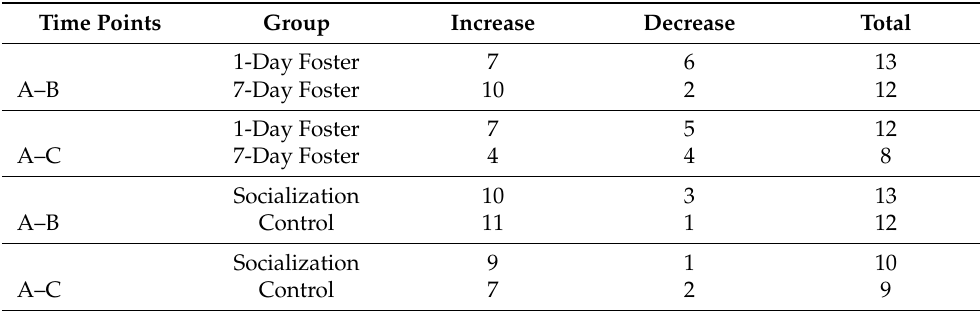
Table 4. Number of cats in each foster group and in-shelter group that had an increase or decrease in the Feline-ality social score from time point A to B and A to C.